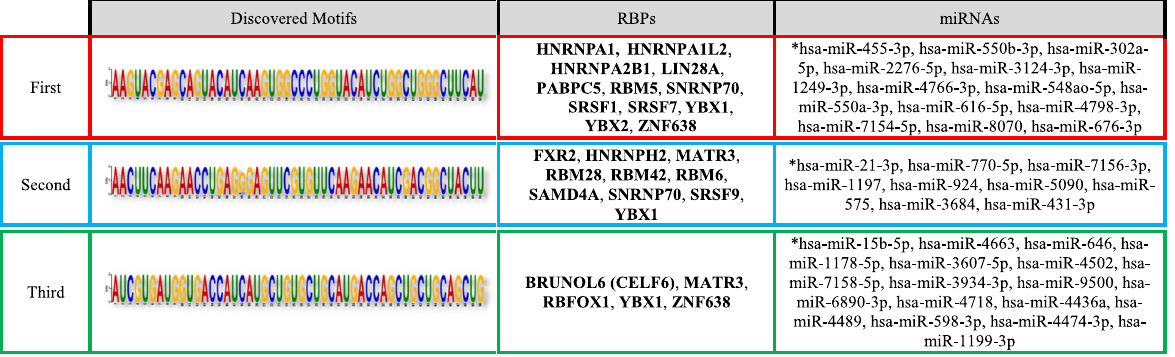
Table 1 The in silico sequences of the three motifs identified in S protein-encoding mRNA, the RBPs capable of binding the sequences, and the miRNAs with similar sequences to the motif are reported in the